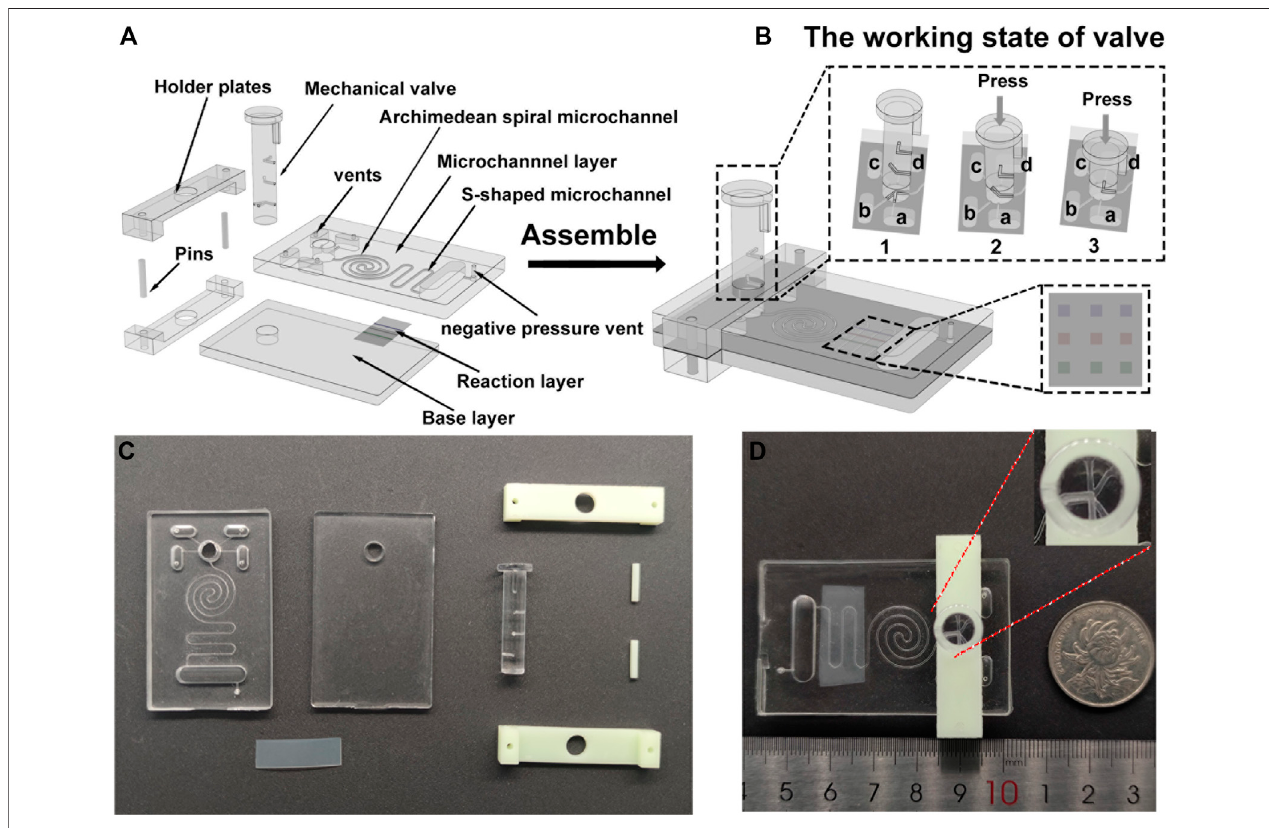
FIGURE 1 | Design and assembly of an integrated SMC with the PM valve for the chemiluminescence immunoassay. (A) Schematic diagram of the top microchannel layer with embedded microchannels, the middle reaction layer with patterned antibody stripes, the base layer, and the PM valve before assembly. (B) SchematicdiagramoftheintegratedchipandtheoperationmanualofthePMvalve.Theinset fi gureistheenlargementofthesideviewforthePMvalveconnectedtothe reservoirs and nine reaction spots on the silicon fi lm. (C) Picture of the SMC mold and PM valve. (D) Image of the assembled SMC.